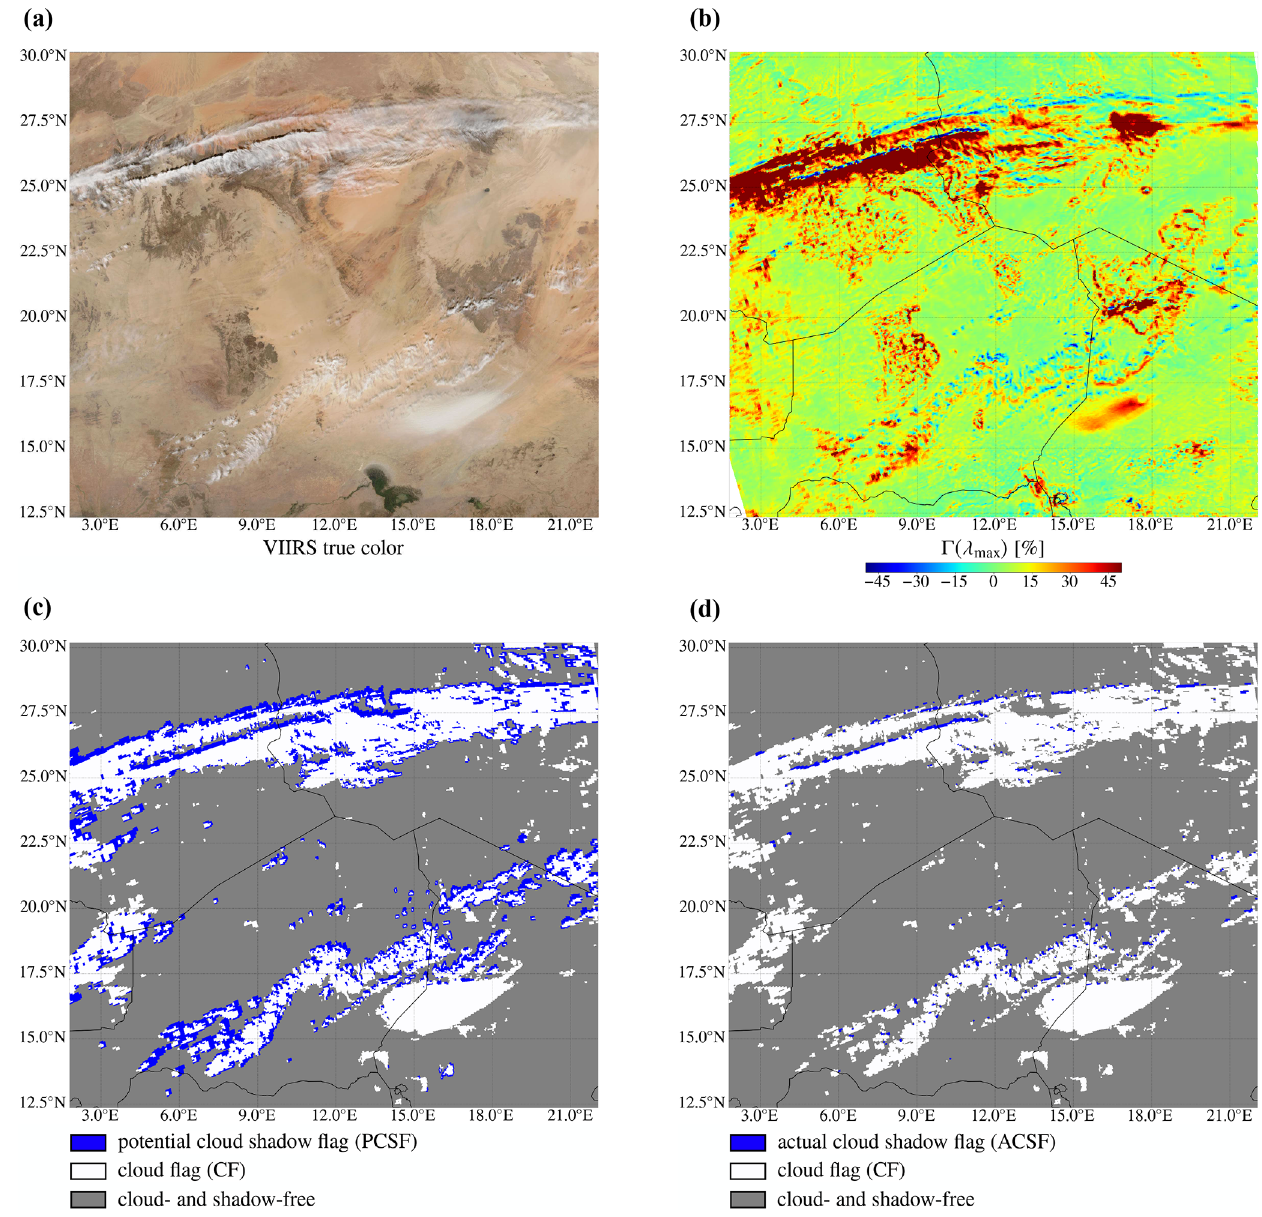
Figure 9. Similar to Fig. 8, but for the Sahara on 18 January